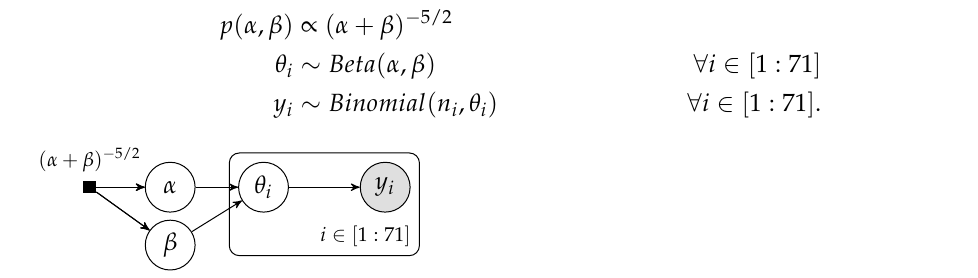
Figure 2. PGM for the rodents example proposed in